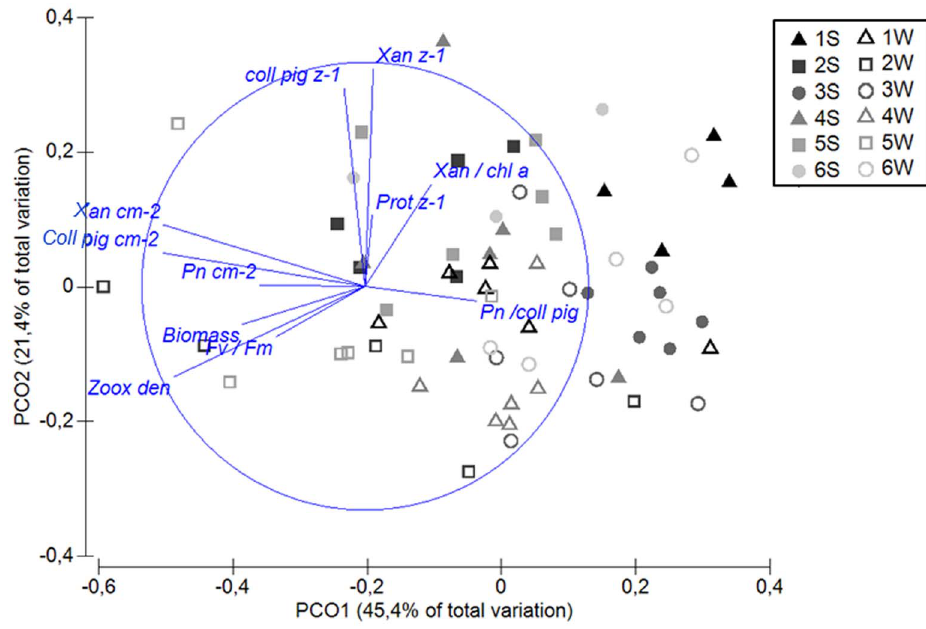
Figure 5. Results of principal coordinate analysis (PCO) (equivalent to PCA, but distances based on chi statistics). Each point represents the combined characteristics of the zooxanthellae at a certain site (1–6) and season (S=end of summer-Sep11, W=end of winter-Mar12) and the vectors represent the importance (length) and direction of the variables in explaining the variation between the points. Only variables contributing to explanation with R 2 . 0.4 are indicated. Xan=Xanthophyll, coll pig=photo-collecting pigments, Prot=protein, Zoox